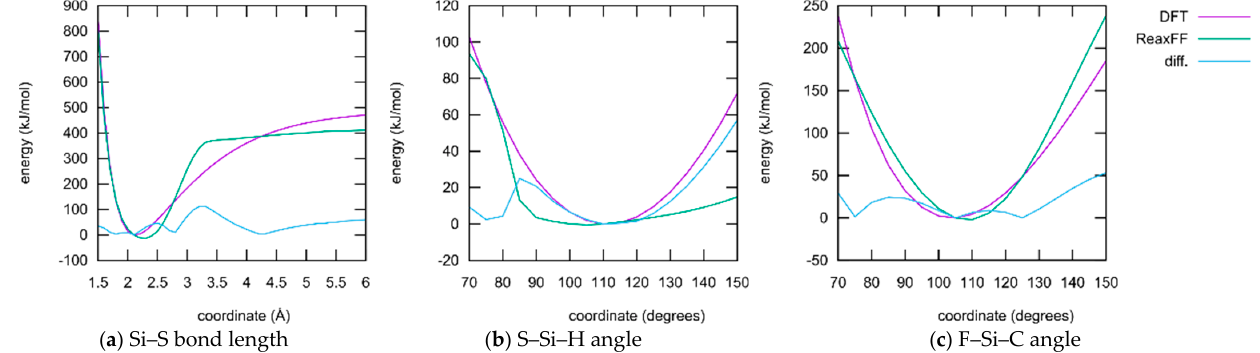
Figure 3. Selected results of the OGOLEM ReaxFF parameter optimization for energy scans (kJ mol − 1 ) in the training set, for the Si–S bond ( a ) and the S–Si–H ( b ) and F–Si–C ( c )